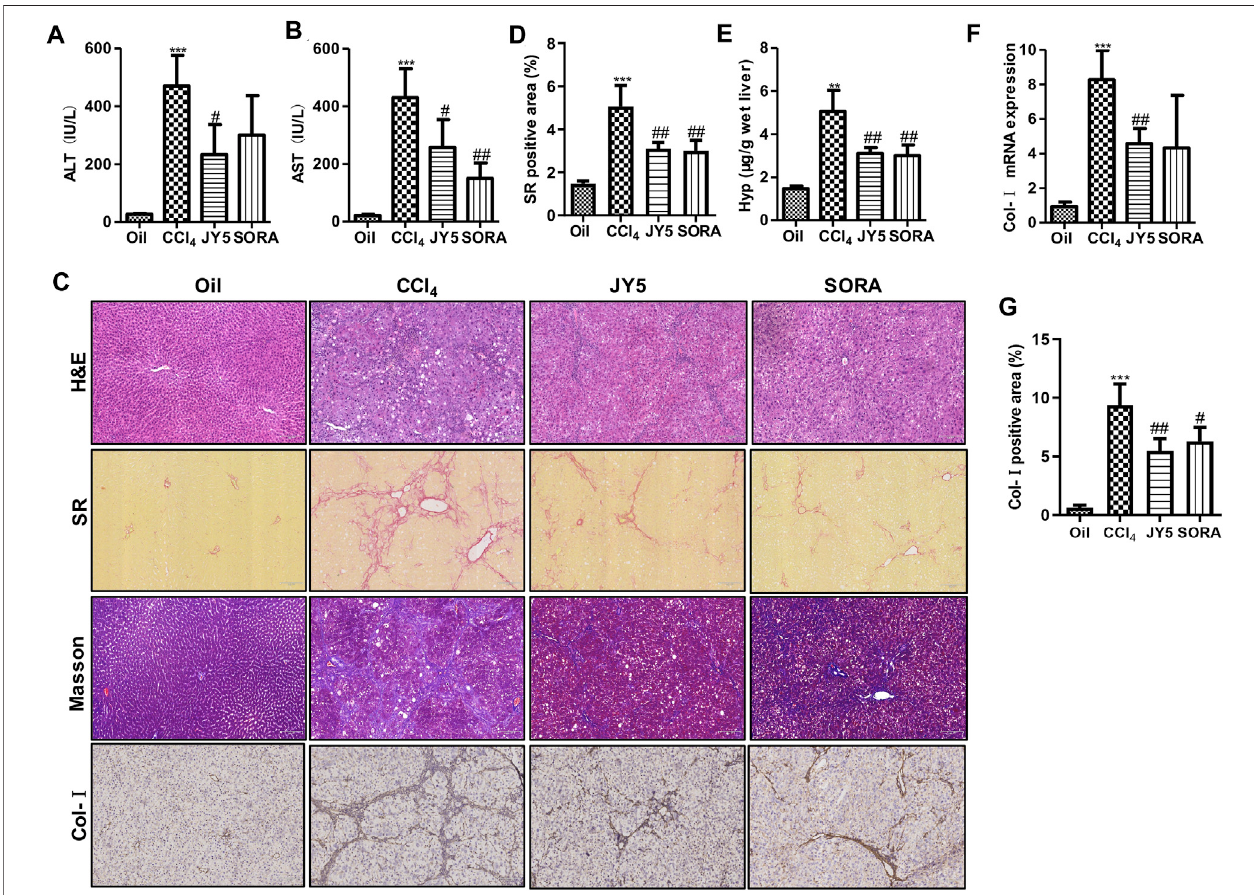
FIGURE 2 | JY5 signi fi cantly alleviates hepatic in fl ammatory injury and collagen deposition in CCl 4 -induced rat liver fi brosis . Serum levels of ALT (A) and AST (B) weremeasuredineachgroup. (C) H&Estaining(100 × ),SRstaining(100 × ),Massonstaining(100 × )andIHCstainingofCol-I(100 × ),andsemi-quantitativeanalysis (D) of collagendisposition(%)inSR-stainedliversections (E) Hypcontentinwetlivertissuewasdetectedbyalkalinehydrolysis. (F) ThemRNAlevelsof Col-I inlivertissuewere analyzed by qPCR. (G) quantitative analysis of immunohistochemical staining for Col-I. ** p < 0.01, *** p < 0.001 vs the control group, # p < 0.05, ## p < 0.01 vs the CCl 4 group. Oil: control